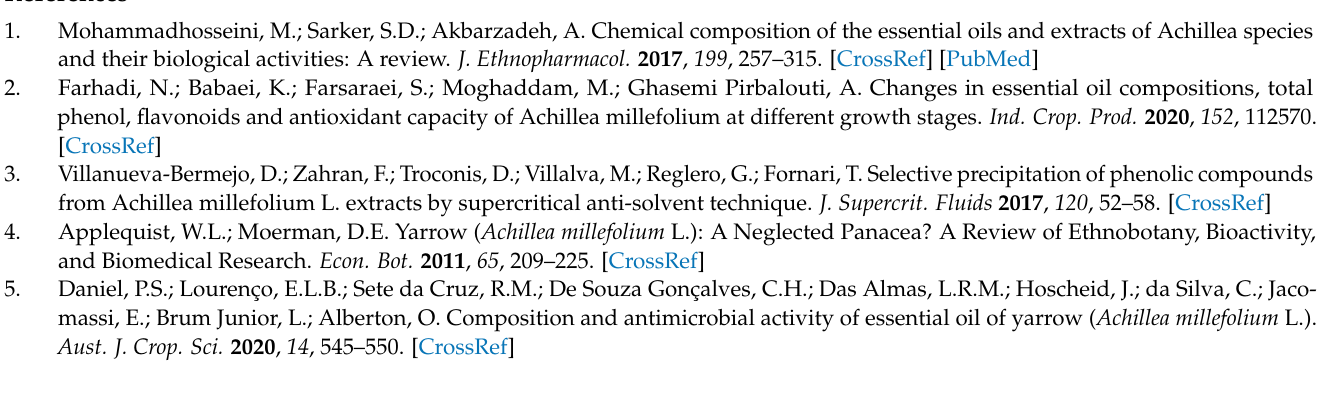
Figure S4: Antifungal activity (MIC) of urea-based NADES (ChCl-U) on Candida albicans ATCC 10231 (C) and Candida albicans isolate (Ci). Figure S5: Antimicrobial activity of choline chloride-urea based NADES (ChCl-U; pure solvent) and ChCl-U extract on Staphylococcus aureus ATCC 25923